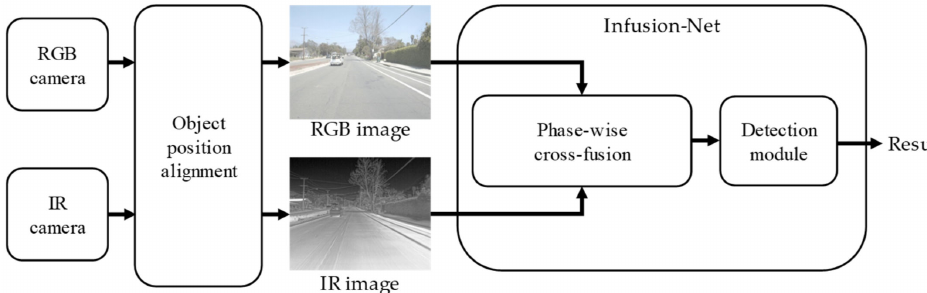
Figure 8. Structure of each phase in the Infusion-Net.